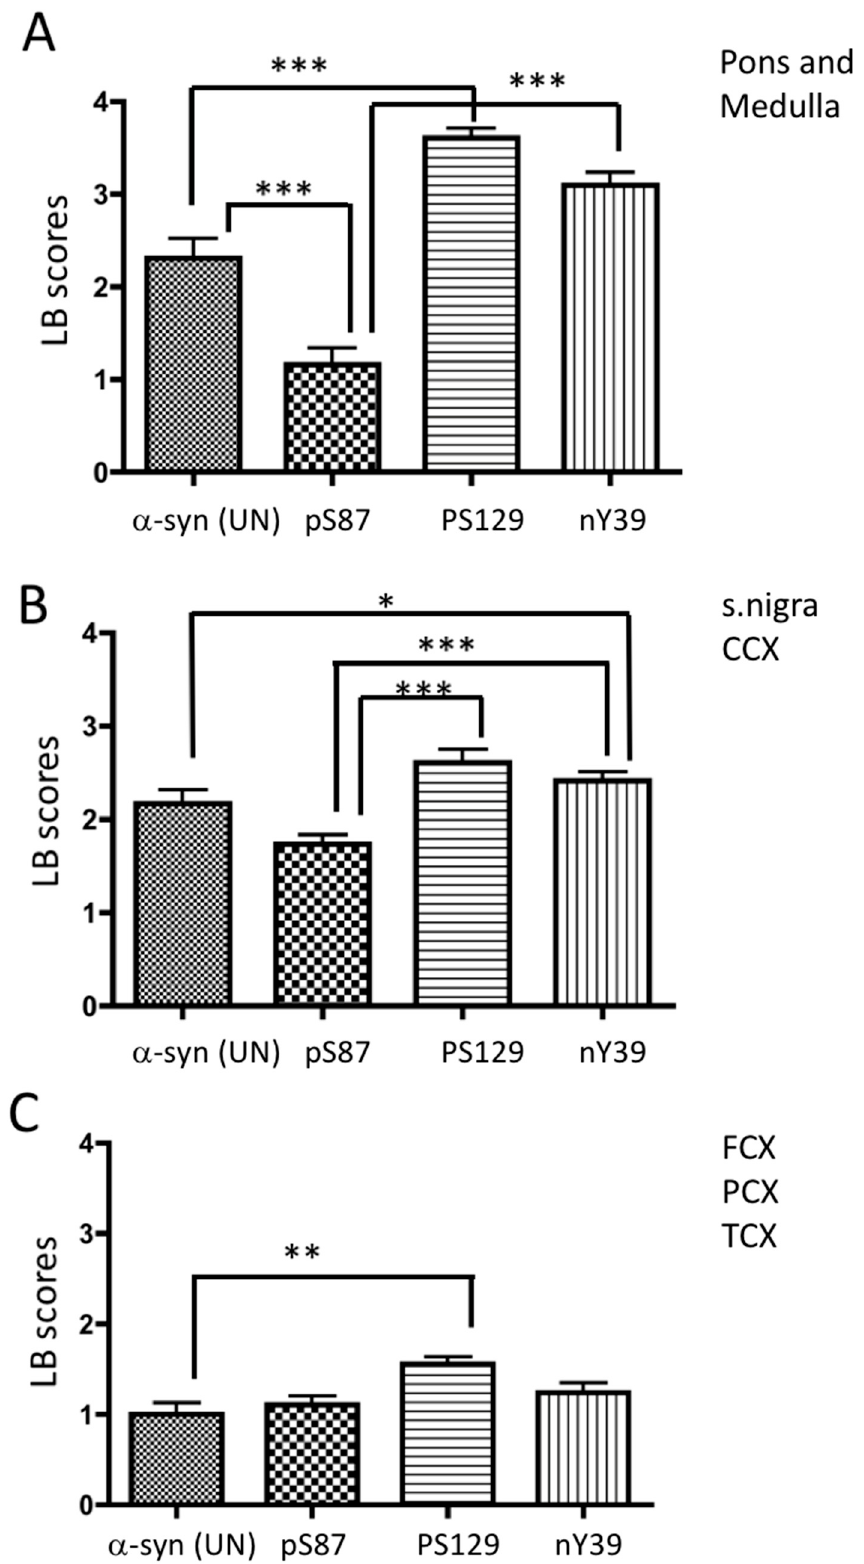
Figure 2. Histogram of cumulative LB scores of different α -synuclein antibodies seen in pons and medulla ( A ); substantia nigra and cingulate cortex (CCX) ( B ); and frontal cortex (FCX), parietal cortex (PCX), and temporal cortex (TCX) ( C ). Statistical analysis was performed using nonparametric Kruskal–Wallis test with Dunn’s multiple comparison corrections. ***, **, and * denote p < 0.001, p < 0.01, and p < 0.05, respectively.